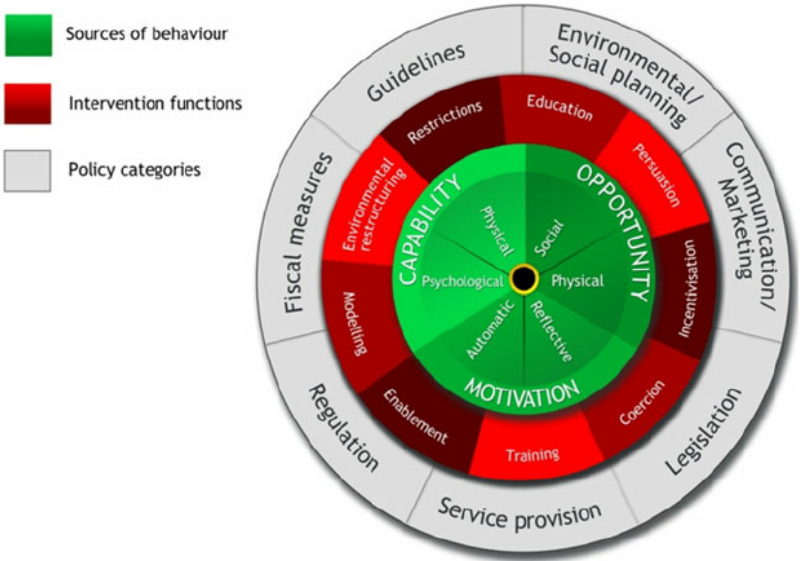
Figure 2. Behavior change